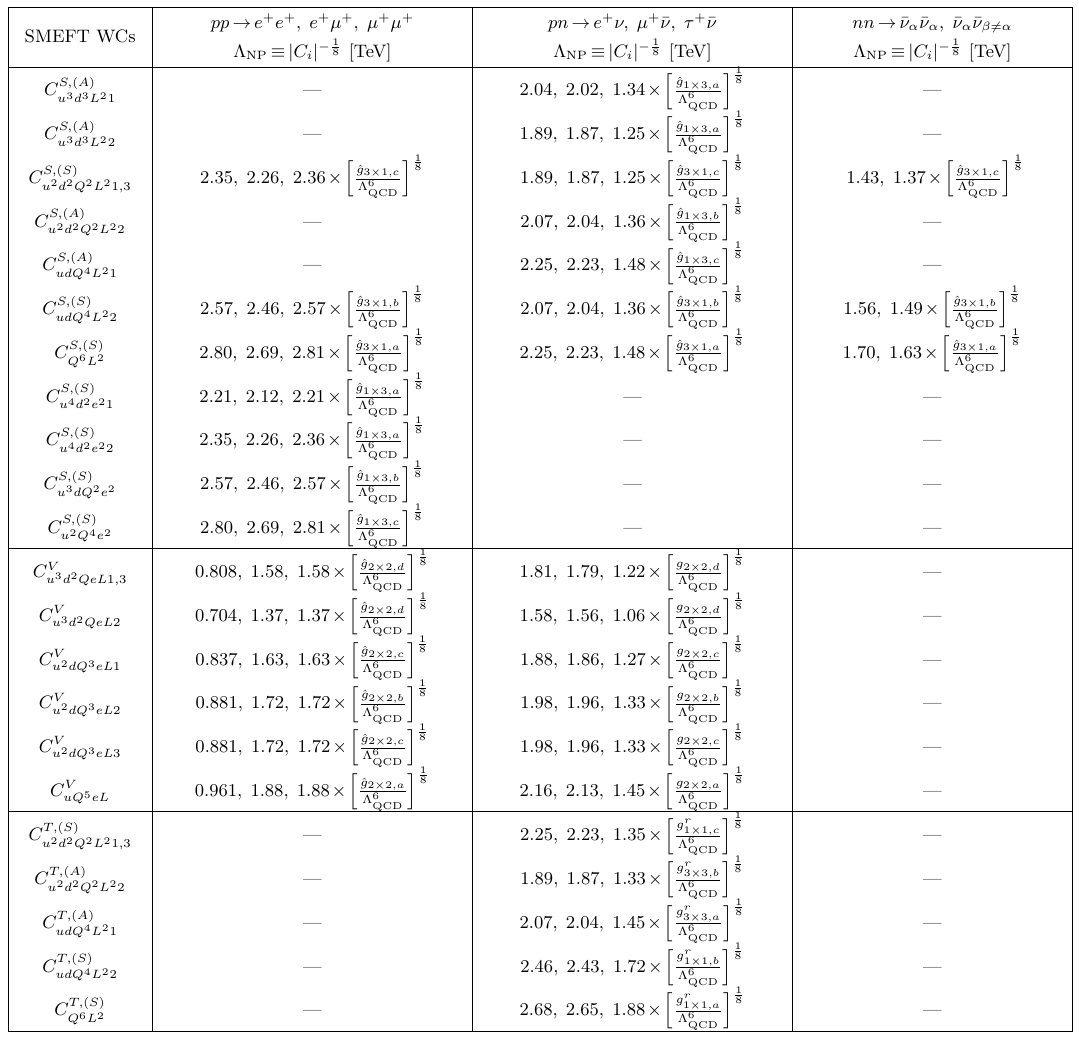
Table 4 . The constraint on the effective NP scale from the current experimental data in table